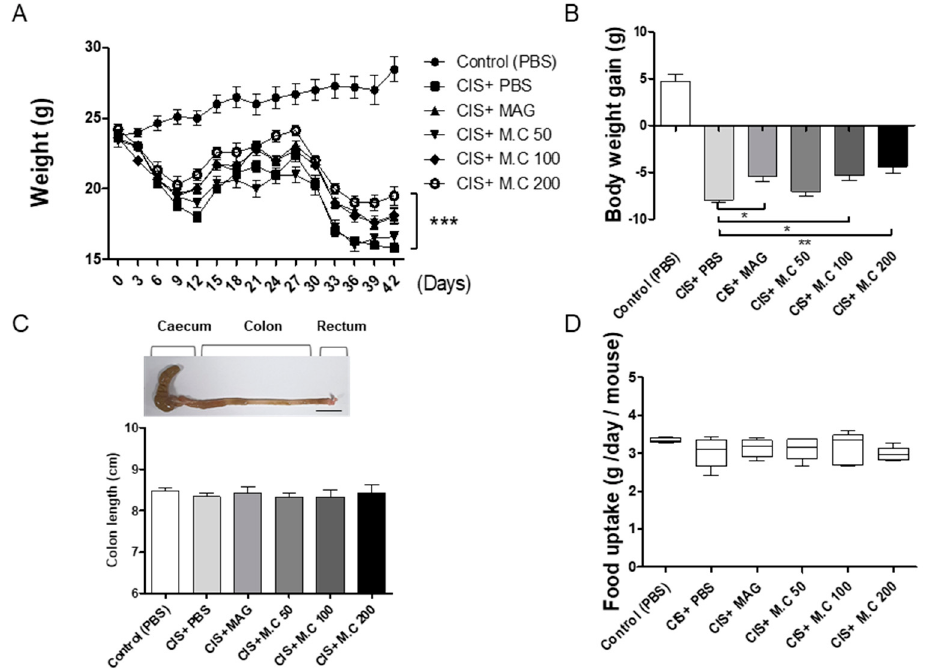
Figure 2. The effect of M.C treatment on body weight loss and dietary intake measurements in mice with cisplatin-induced sarcopenia. To induce muscle damage, cisplatin (2.5 mg/kg) was administered on days 1–5 and 26–30. Magnolol (10 mg/kg) was administered intraperitoneally every 3 days, for a total of 12 times. M.C (50, 100, and 200 mg/kg) was administered orally every 3 days, for a total of 12 times. Mice were sacrificed on day 42: ( A ) weight changes in the sarcopenia mouse model. Data are presented as the mean ± SEM ( n = 10/group). * p < 0.05, ** p < 0.01, *** p < 0.001 vs. cisplatin, using a Bonferroni post hoc test after two-way ANOVA; ( B ) weight changes in the sarcopenia mouse model presented as % vs. control (42 days); ( C ) representative colon images (scale bar 1 cm) and colon length measurement; ( D ) average daily feed intake per mouse. Data are presented as the mean ± SEM ( n = 10/group). * p < 0.05, ** p < 0.01, *** p < 0.001 vs. cisplatin (CIS)+phosphate-buffered saline (PBS), using a Bonferroni post hoc test after one-way